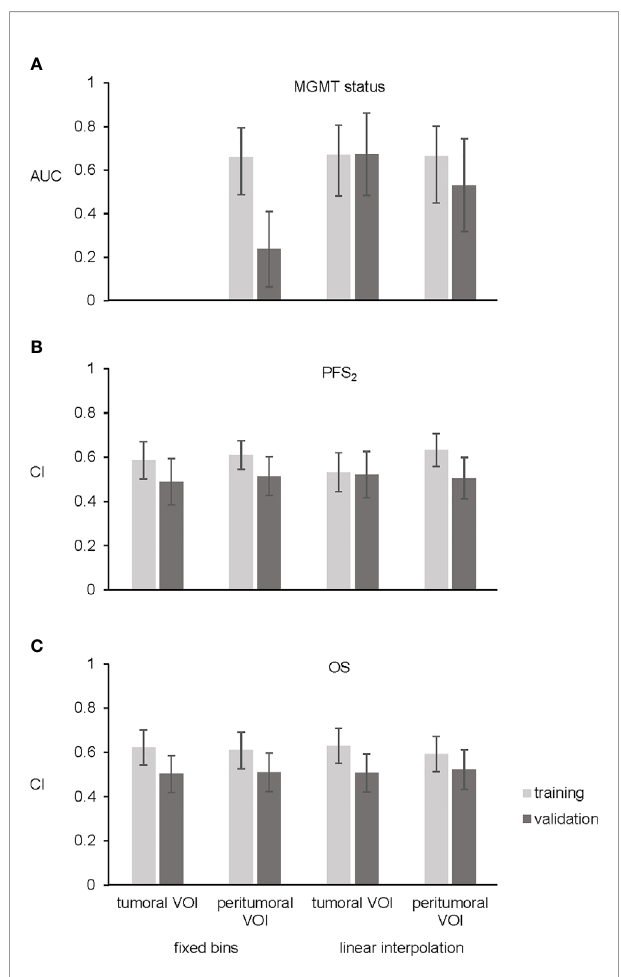
FIGURE 2 | Bar plots. (A) Shows area under receiver operating characteristic curve (AUC) of the three fi nal models for MGMT status. No signi fi cant features were found for prediction of MGMT status using tumoral VOI and fi xed number of bins. (B) Four fi nal models for PFS 2 showing concordance index (CI). (C) CI of the four fi nal OS models. Training cohort in light gray and validation cohort in dark gray. Error bars representing 95% con fi dence interval.